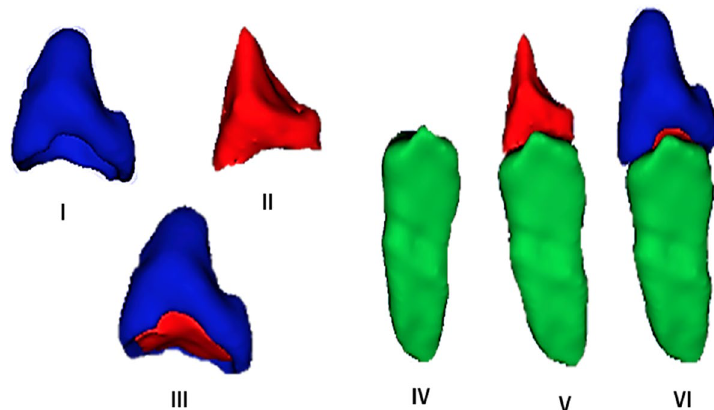
Fig. 1 Six sets of dental tissue segmented and considered for sexual dimorphism in the present study. (I) Volume of enamel (Ve), (II) volume of coronal dentine and pulpal dentine (Vcdp), (III) total crown volume (VC), (IV) volume of the root (Vr), (V) total dentine including pulpal dentine (VTDP), and (VI) total tooth volume